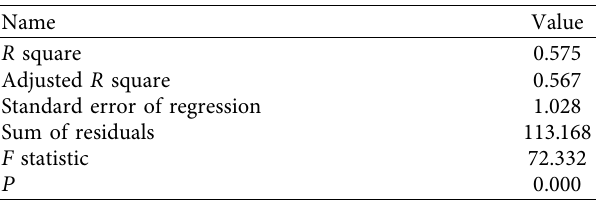
Figure 14: Velocity variation error-mean velocity variation in a window width of 8ms-discrimination threshold relationship diagram. Table 13: Statistics of the linear model (mean velocity variation in a certain window width).